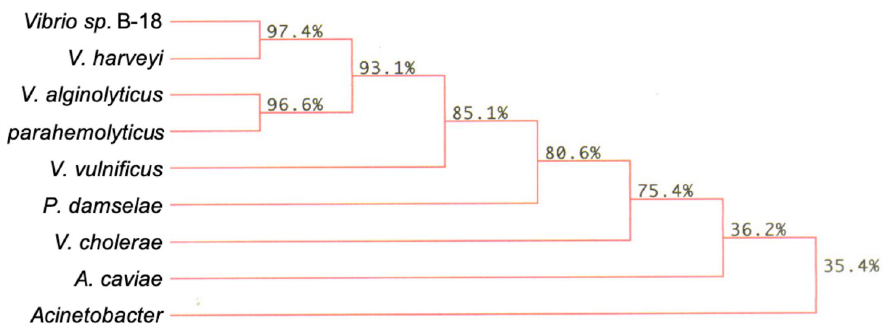
Fig 2. Phylogenetic tree of the phaC gene product from Vibrio B-18 from BLAST and Higgins Sharp alignment (MacDNAsis). The numbers indicate the percent identity in the aligned proteins. Genbank protein